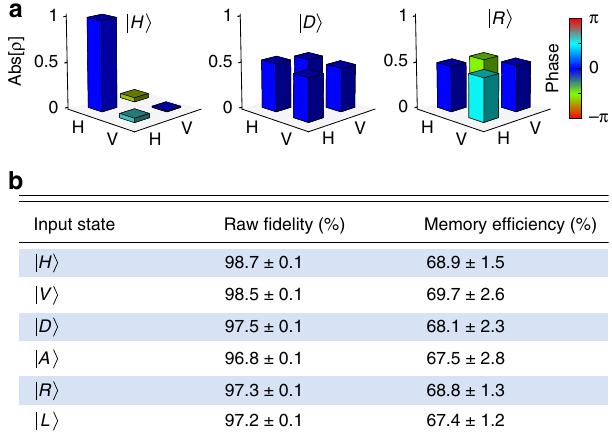
Fig. 3 Quantum state tomography of the retrieved polarization qubits. a Reconstructed density matrices for the retrieved states after a 1.2- μ s storage time. The height of the bar represents the absolute value while the color denotes the phase. No background has been subtracted. b Conditional fi delities and memory ef fi ciencies for the set of six input qubits. The error bars for the fi delity are estimated by taking into account the statistical uncertainty of photon counts. The error for the ef fi ciency is obtained from multiple measurements. The mean number of photons per pulse is n ¼ 0 : 5